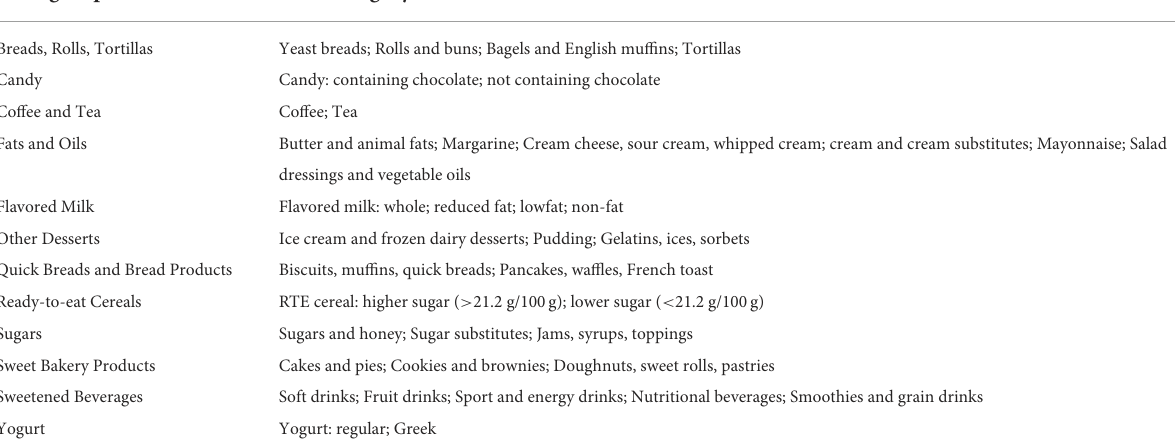
TABLE 1 Breakdown of food groups into types of foods [WWEIA categories (26)] that provide added sugars. Food